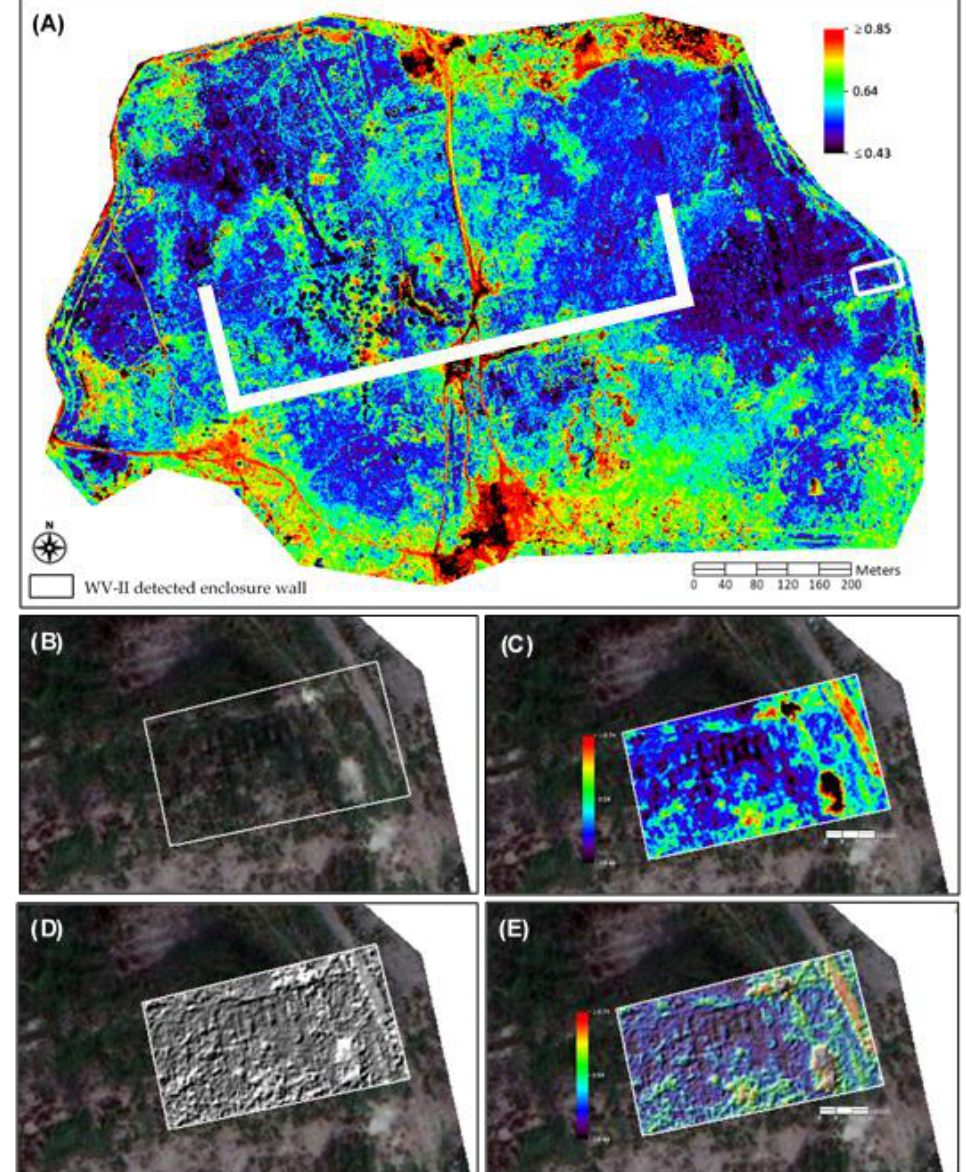
Figure 9. WorldView New Iron Index (WV-II) for the entire study area with the detected site highlighted in the white box. The WV-II-identified lower section of the city’s known mudbrick enclosure wall is also highlighted in white. The detection of this wall is due to the presence of mid to high iron oxide content (A). WV-3 true color image showing the area covered by surface vegetation (B). Installation G revealed by very low WV-II content (C). Linear feature visible using edge-detection spatial filtering (D). WV-II overlaid onto the edge detection in order to accentuate the buried linear structure (E).